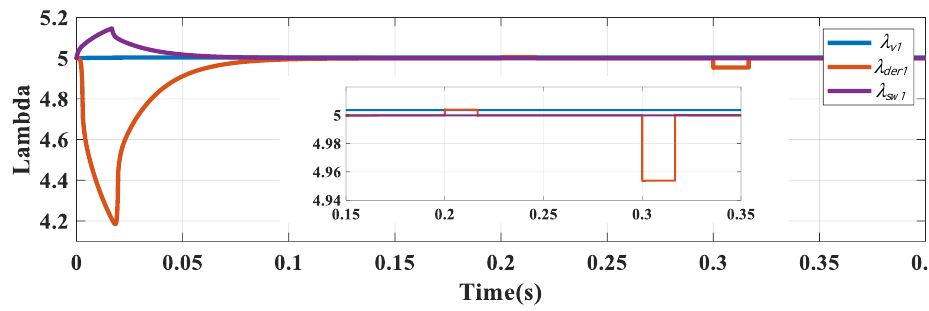
Figure 9. Study 1: generated weighting coefficients for FCS-MPC in